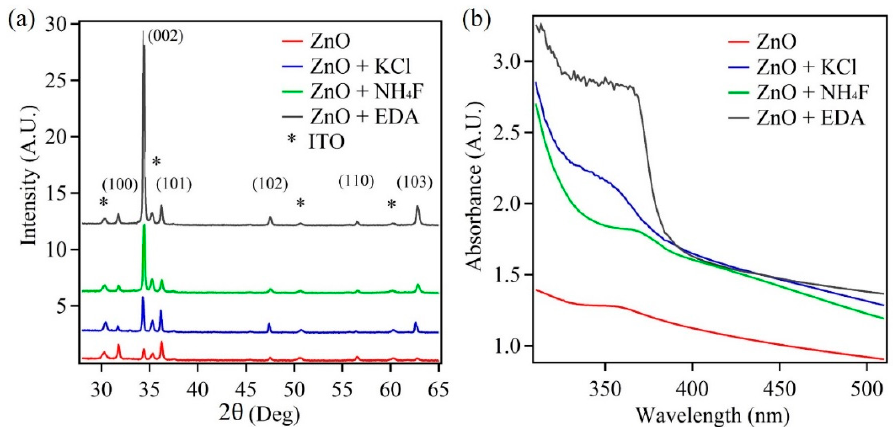
Figure 1. ( a ) XRD plot and ( b ) UV–Vis absorption spectra of the ZnO nanostructures.